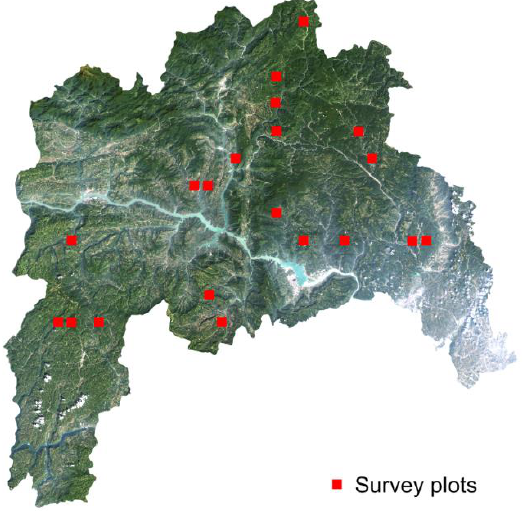
Figure 14. Spatial distribution of the survey plots.